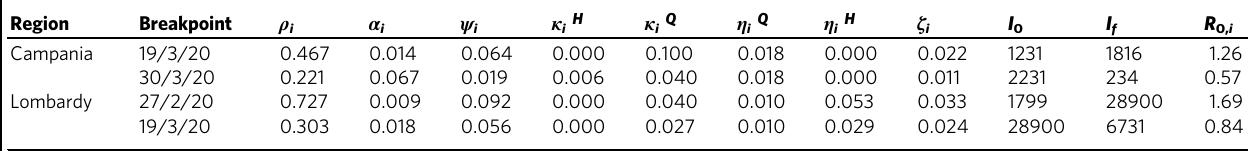
These regions are highlighted in a darker colour in Fig. 1. Here, I 0 is the number of infected estimated in the region at the beginning of each time window, while I f is the number of infected at the end of each time window estimated by running the model (14) – (16), given the set of identi fi ed parameters and the initial condition on the infected I 0 . The fi rst breakpoint is the date when 10 deaths and 10 recovered were fi rst reported in the region and the analysis started. The second breakpoint is the end of the fi rst window and the start of the second window (ending on May 3, 2020).